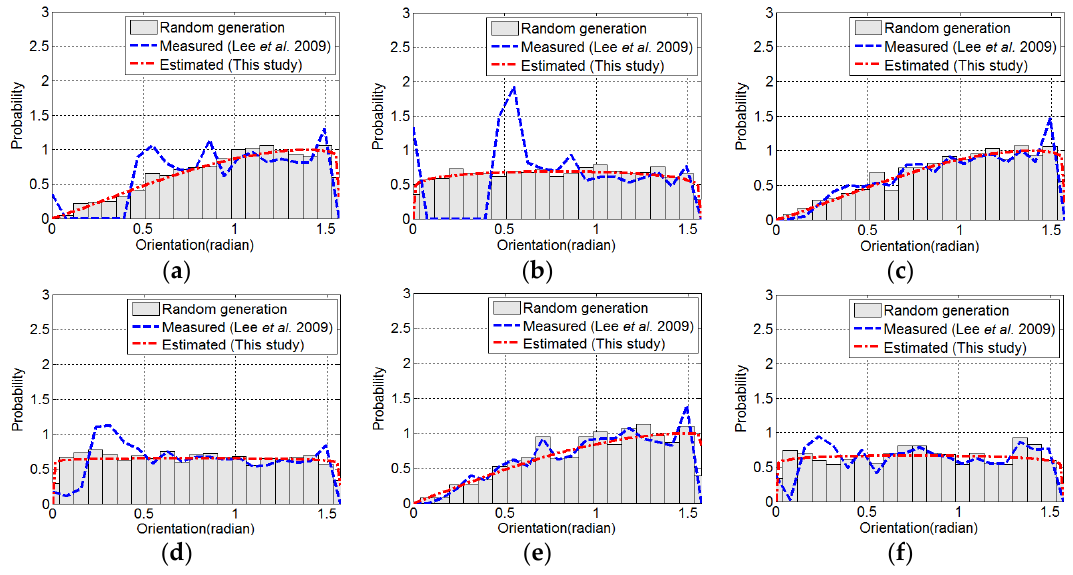
Figure 12. Comparison between the measured distribution and the estimated distribution by the technique proposed in this study: ( a ) I05-3; ( b ) I05-2; ( c ) I15-3; ( d ) I15-2; ( e ) I25-3; ( f ) I25-2.